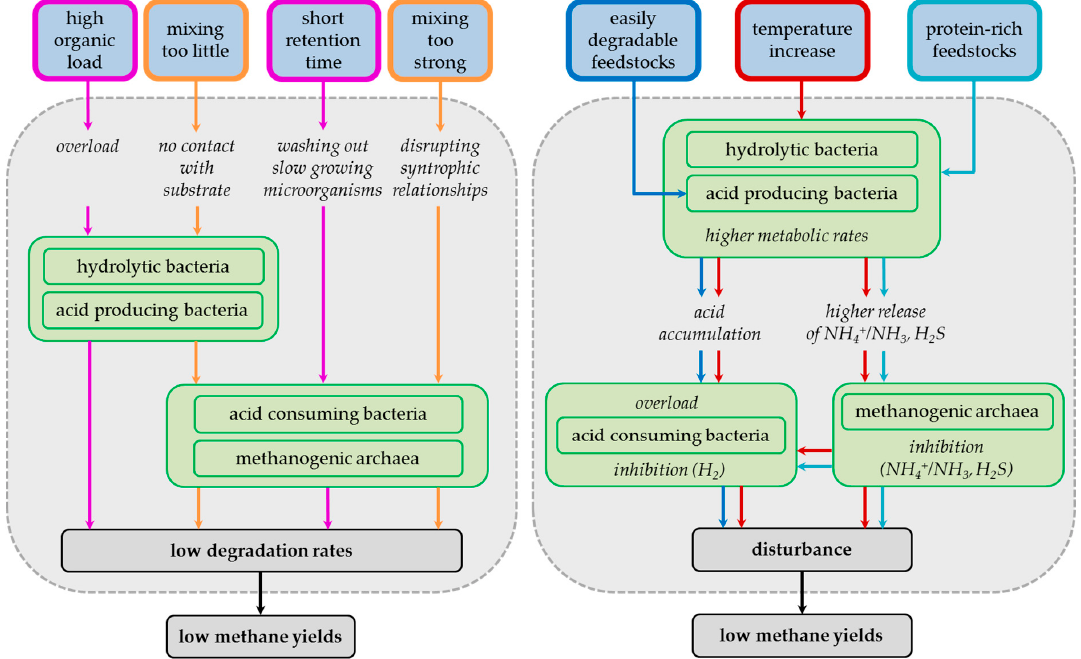
Figure 3. Causes, mechanisms and effects of process disturbances on the biogas microbiome (dashed (dashed line—microbial system; blue boxes—management measures causing process line—microbial system; blue boxes—management measures causing process disturbances; green disturbances; green boxes—microorganisms affected in the four steps of the digestion process; boxes—microorganisms affected in the four steps of the digestion process; colored arrows—cause– colored arrows—cause–effect chains of disturbance effect chains of disturbance types).